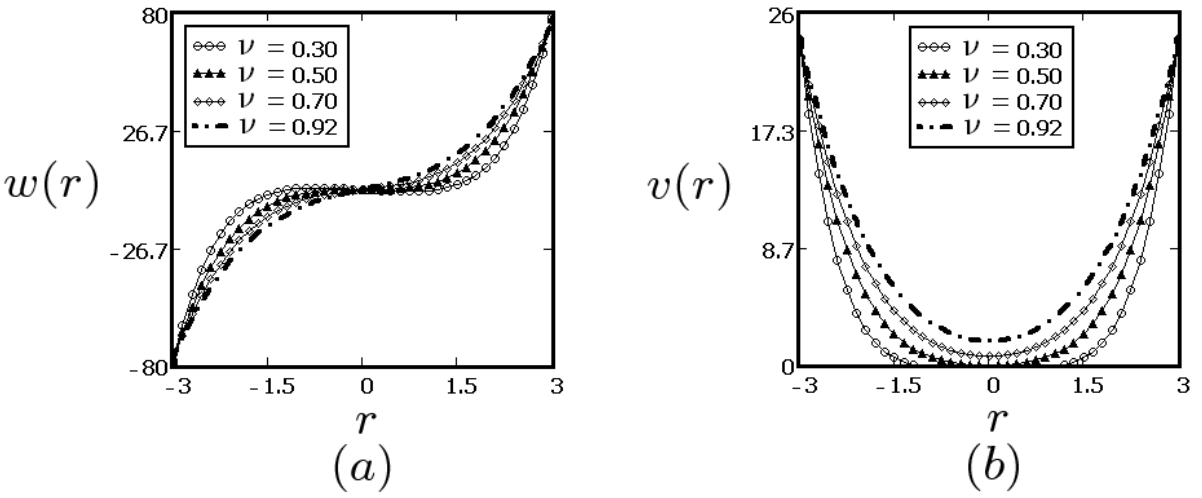
Fig. 5: Profiles of the velocity components w ( r , t ) and v ( r , t ) given by Eqs. (32) and (33), for R = 3, Ω = 1, U = 1, ρ = 27.981, λ = 3, α = 0.5, p = 2, t = 5 s and different values of ν